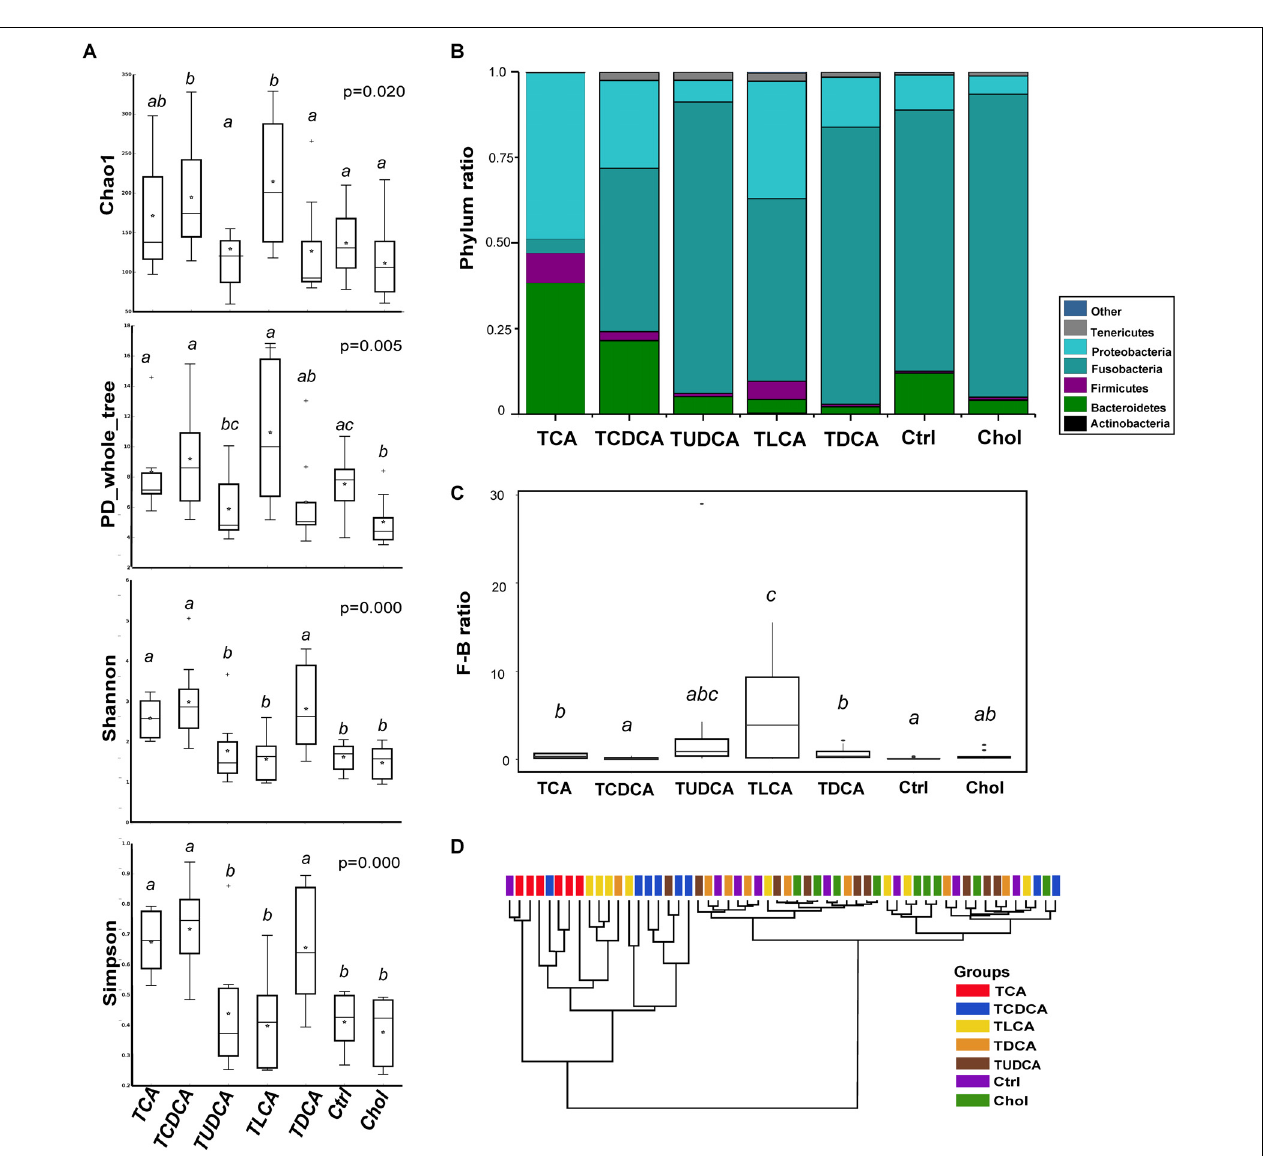
FIGURE 2 | Effects of different dietary bile salts on shaping the hindgut microbiota in grass carp. (A) Microbial alpha diversity in each group was calculated using four different parameters: Chao1, PD_whole_tree, Shannon and Simpson. P -value was evaluated with Kruskal–Wallis test. (B) Microbial composition of each group at the phylum level. (C) The ratio of microbial Firmicutes/Bacteroidetes (F/B ratio) taxa in each group. (D) Cluster analysis performed on Bray–Curtis distance matrices of bacterial OTUs using an unweighted pair group mean (UPGMA) algorithm. Different letters above bars indicate statistically significant ( P < 0.05) differences between groups (A,C) . For the TCA fed group, n = 6; for the TCDCA, TLCA, TDCA, and Ctrl groups, n = 8; for the TUDCA and Chol groups, n =